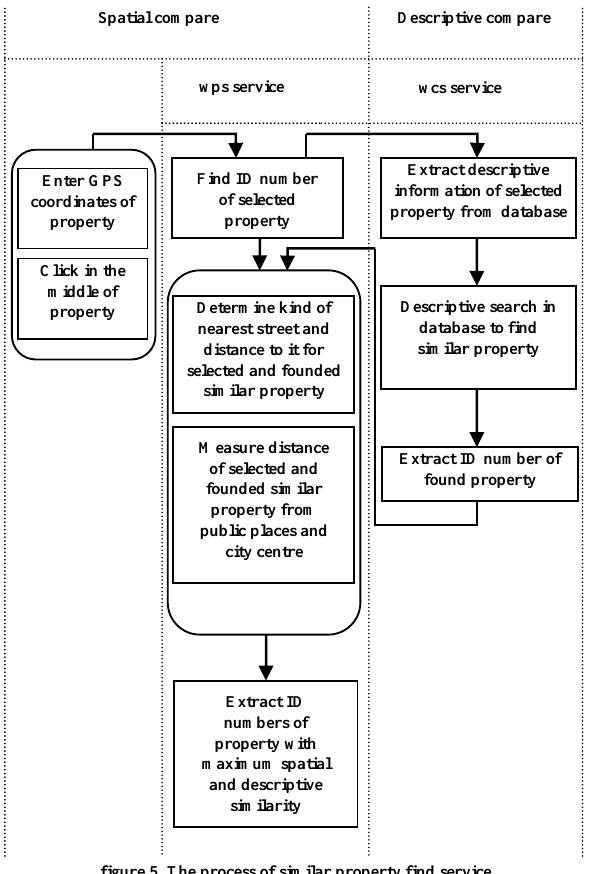
figure 5. The process of similar property find